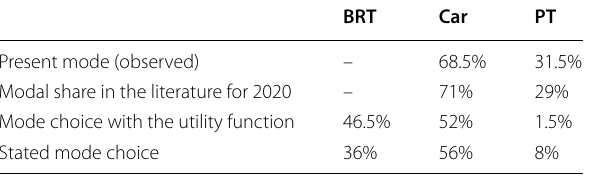
Table 7 Observed and estimated modal shares